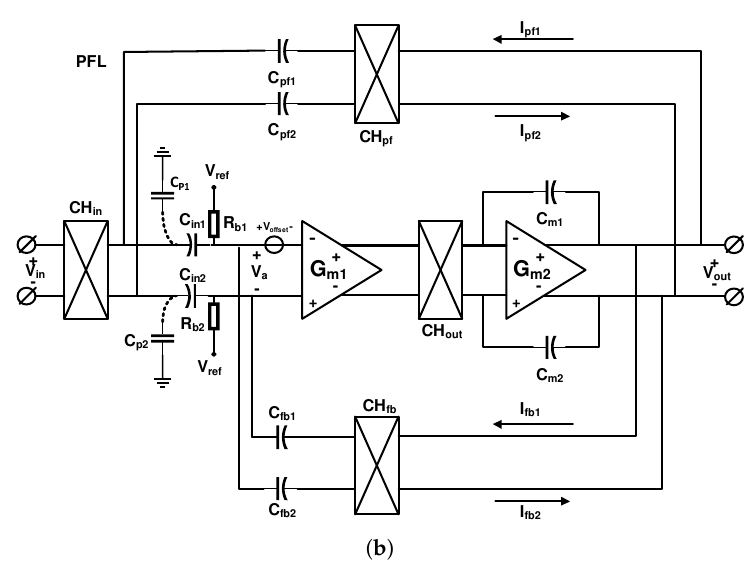
Figure 10. Chopper switches placed in front of the AC-coupling capacitors. ( a ) Circuit architecture of a neural amplifier, illustrating two loop feedback paths to define the midband gain and high pass corner; ( b ) schematic of the capacitively-coupled low noise amplifier (LNA) with the positive feedback loop for input impedance boosting.